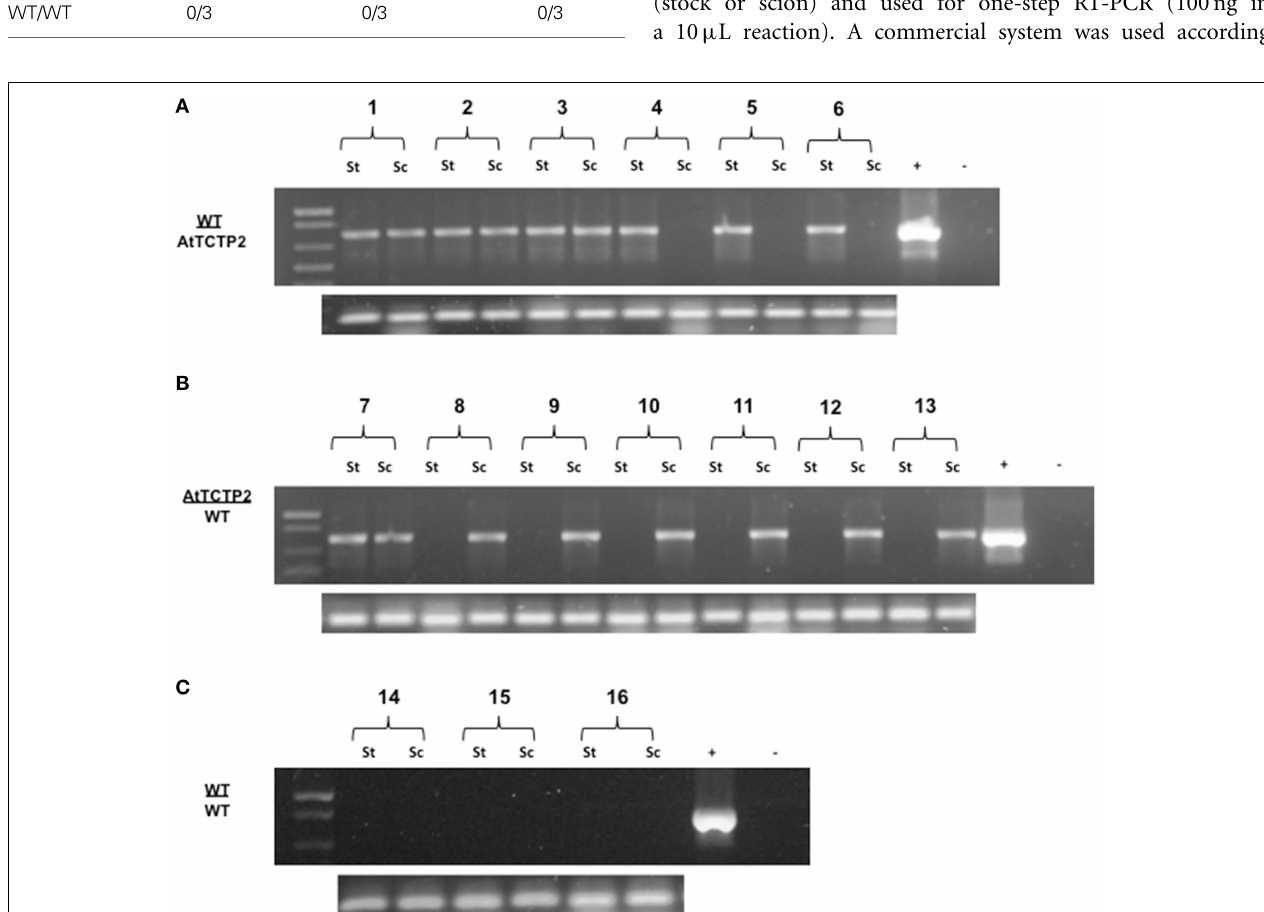
FIGURE 1 | Detection of AtTCTP2-GFP mRNA long-distance movement in tobacco grafts. Total RNA samples from stocks and scions (transgenic or WT) were extracted and used as templates to perform RT-PCR detection of the transcript AtTCTP2-GFP. For further propose we denote grafts as scion (apex) genotype/rootstock genotype. (A) In WT/AtTCTP2 grafts the mRNA